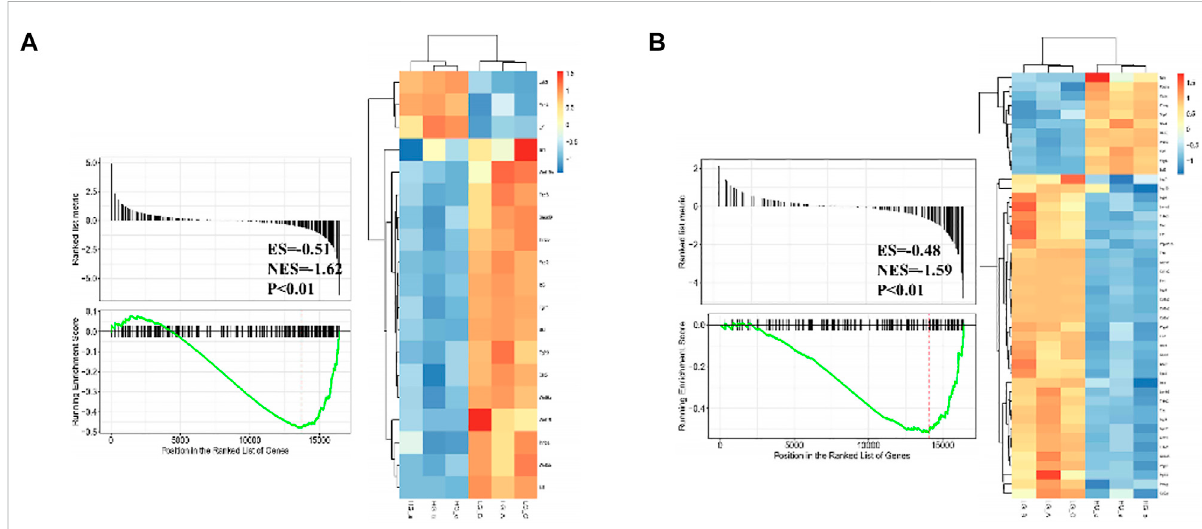
FIGURE 6 GSEA plot showing most enriched gene sets of all detected genes from BMSCs in high glucose microenvironment at 35 mM concentration for 30 days.